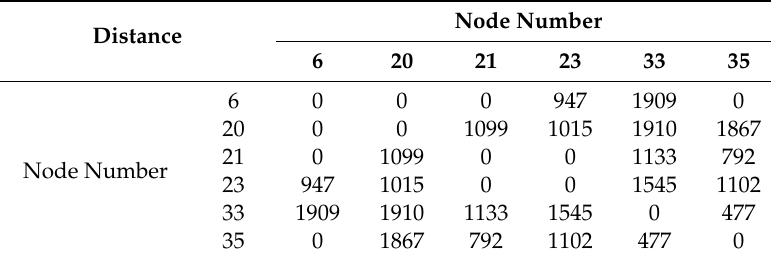
Table 4. Air transportation distance relationships (Unit: km).